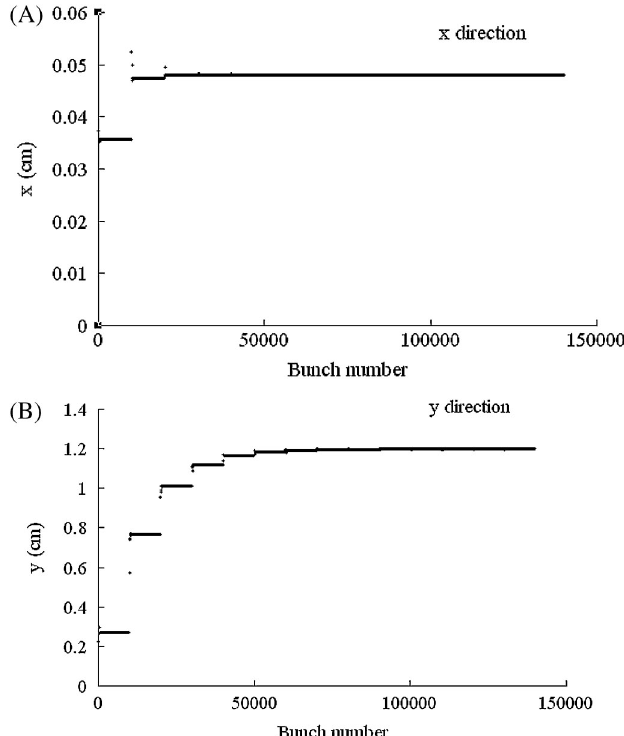
FIG. 15. BBU threshold simulation of slotted cavity. Beam current is 1.5 A (accelerating beam). Injected energy ¼ ¼ 20 MV = m , final electron-beam energy ¼ 10 MeV , E acc 7 GeV . The vertical axes of the two plots are the displacement of the bunch leaving the accelerator as a function of bunch number: (A) x direction of the cavity (horizontal); (B) y direction of the slotted cavity